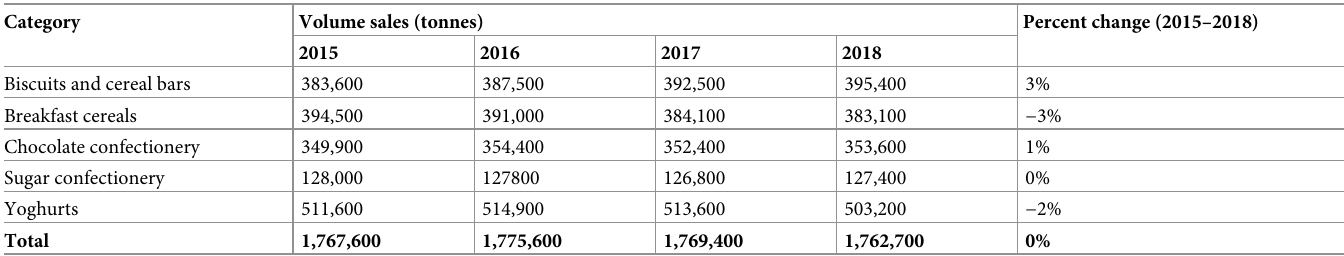
Table 3. Total volume sales of food category in tonnes,